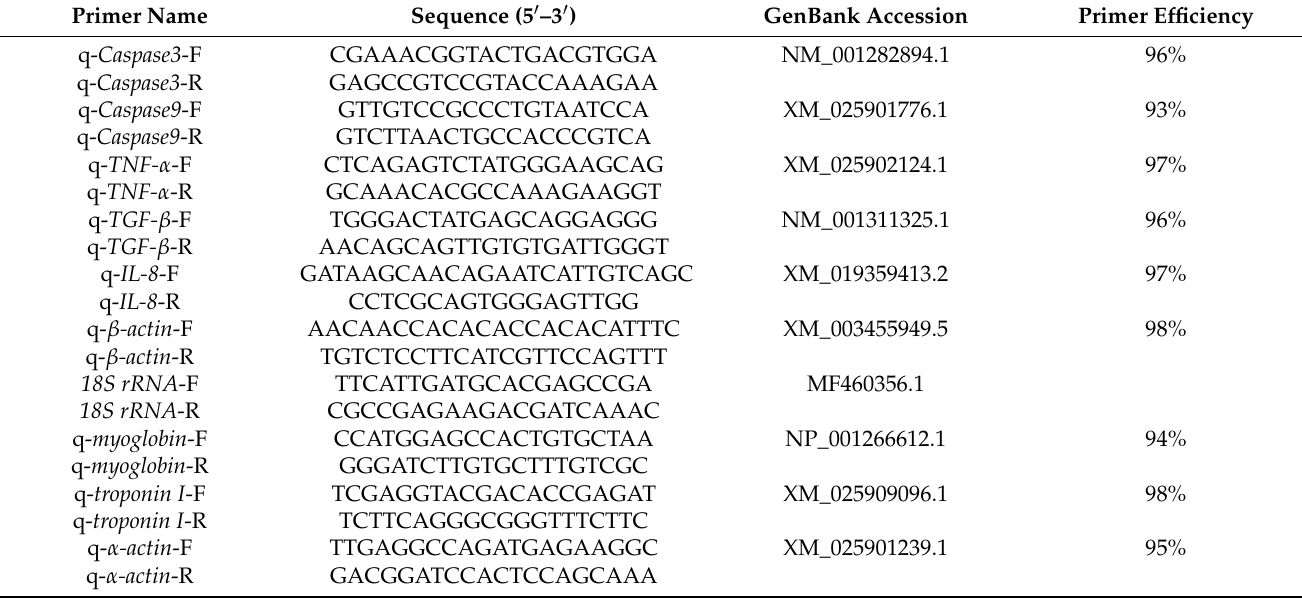
Table 1. Sequences of primers used in this